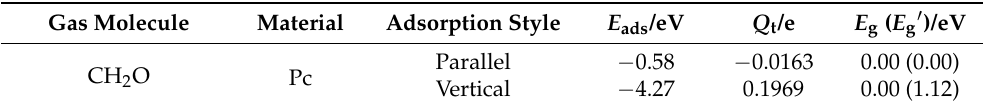
Figure 4. Top and side views of original structure before adsorption on Pc monolayer: ( a 1 ) CH 2 O-P and ( b 1 ) CH 2 O-V, and the optimized structure of different adsorption systems ( a 2 ) CH 2 O@Pc-P and ( b 2 ) CH 2 O@Pc-V. Table 1. The adsorption energy ( E ads ), charge transfer ( Q t ), and band gap of the system before adsorption ( E g ) and after adsorption ( E g ′ ) for the CH 2 O@Pc adsorption system.